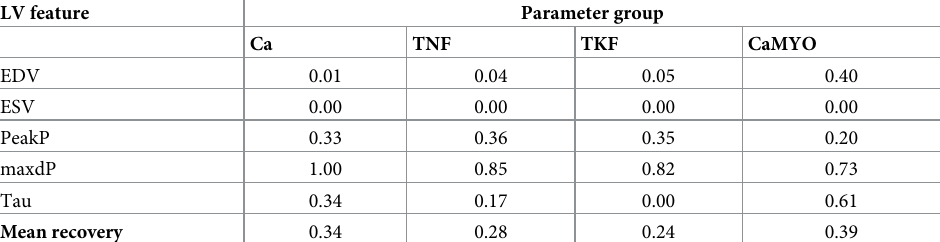
Table 4. LV features’ percentages of recovery. For each LV feature we aimed to recover, the distance between its median recovered value and the respective healthy value is divided by the distance between the initial, diseased value and the healthy value. This ratio describes the percentage of recovery for the examined